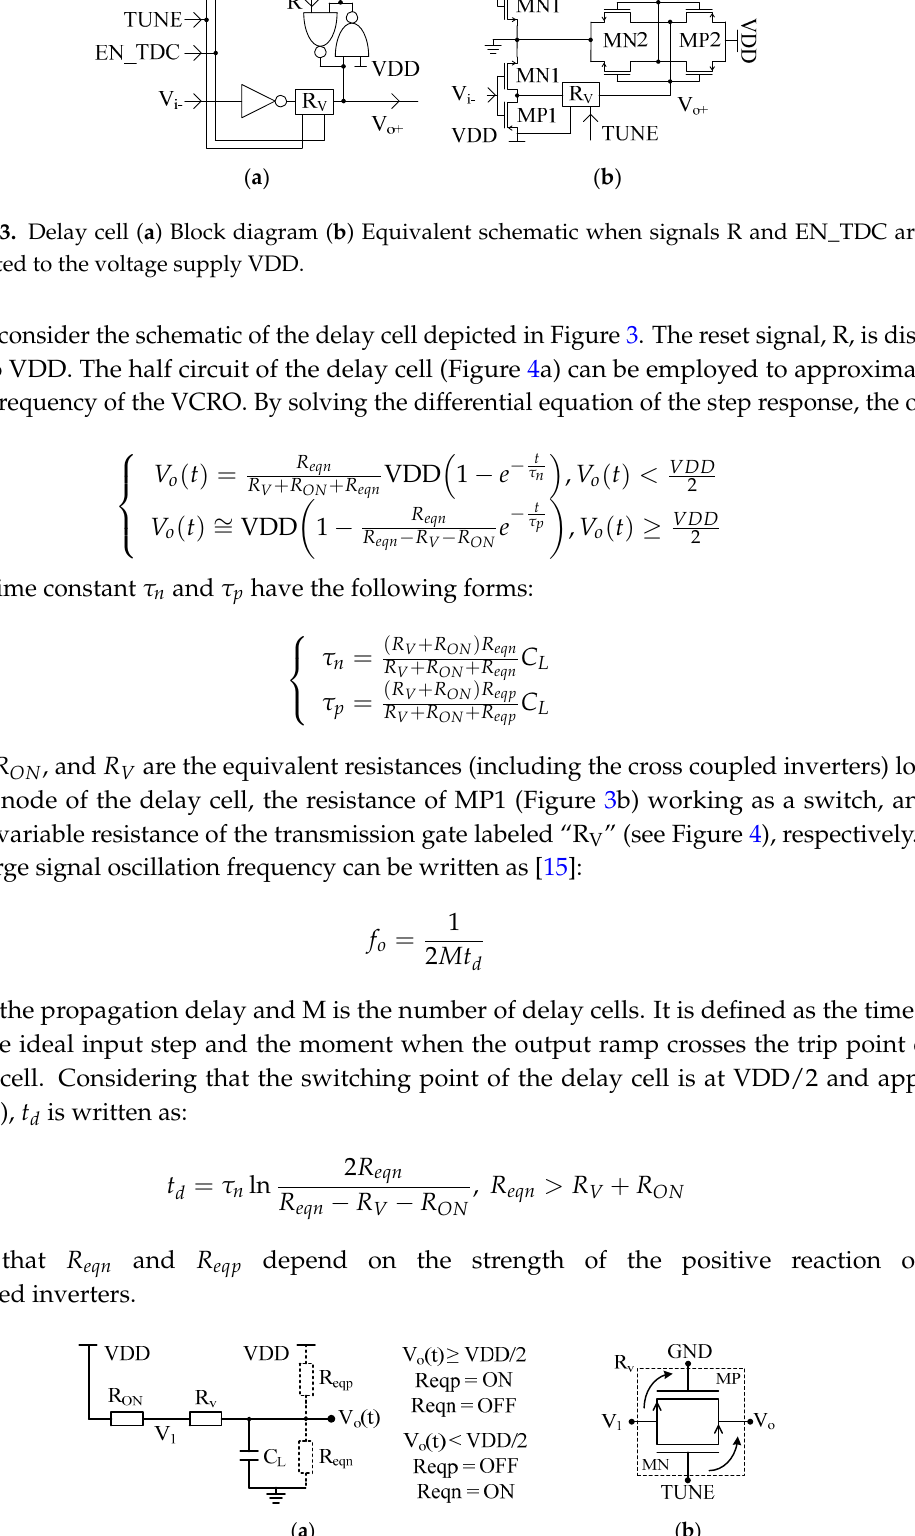
Figure 4. ( a ) Half circuit of the delay cell when the output capacitance C L is charging; ( b ) schematic of the R V block when EN_TDC is connected to VDD.